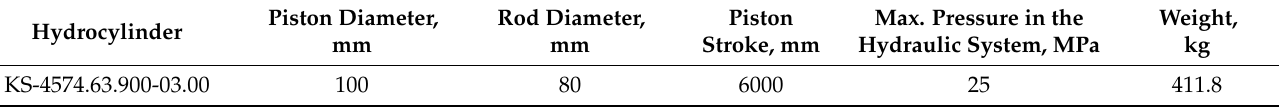
Table 2. General characteristics of the hydrocylinder for telescoping the truck crane beam. Piston Diameter, Rod Hydrocylinder mm